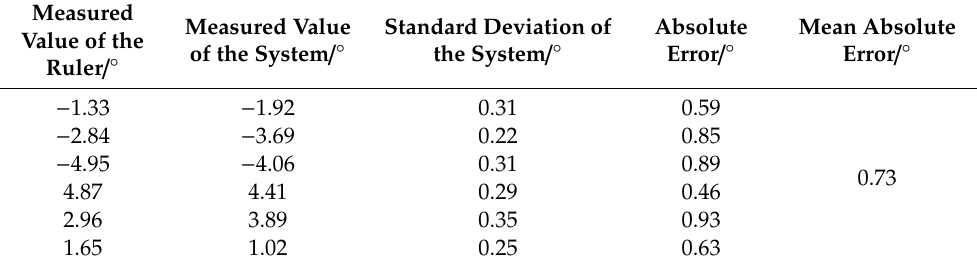
Table 3. Dynamic experiment results of the integrated